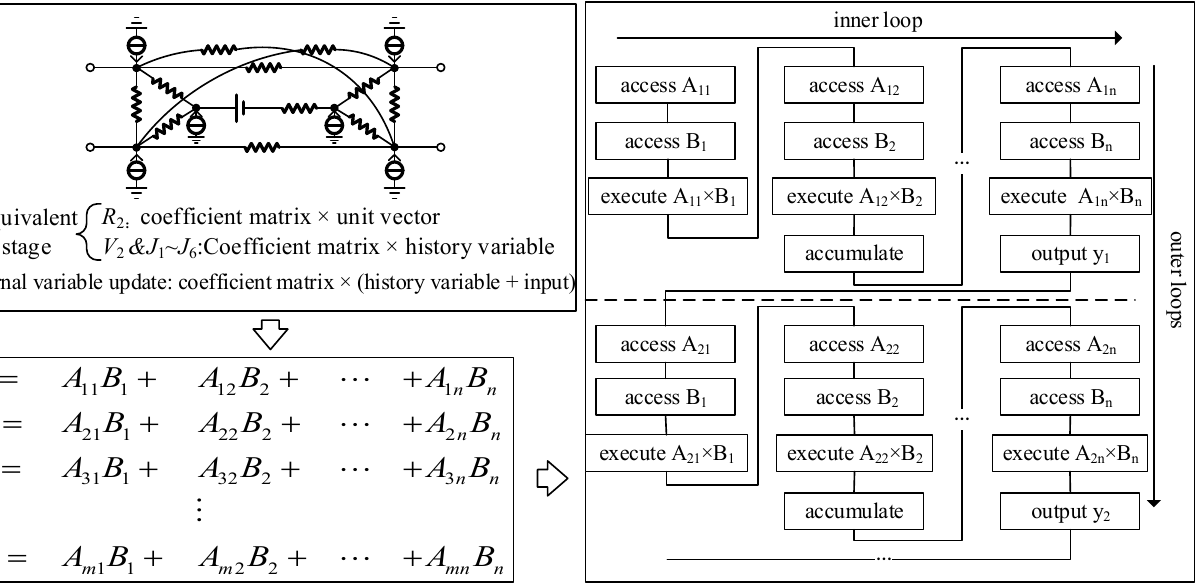
Figure 10. Computational features of matrix–vector multiplication.